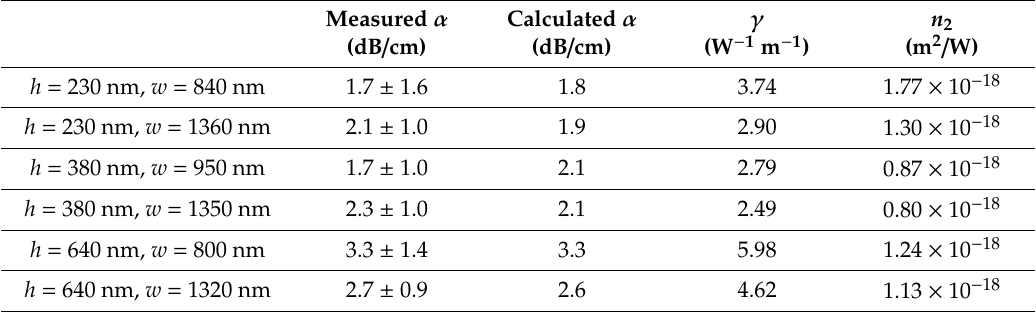
Table 1. Summary of the linear and nonlinear properties of the fabricated silicon-rich nitride ridge waveguides with various rib heights ( h ) and widths ( w ) at 1950 nm.